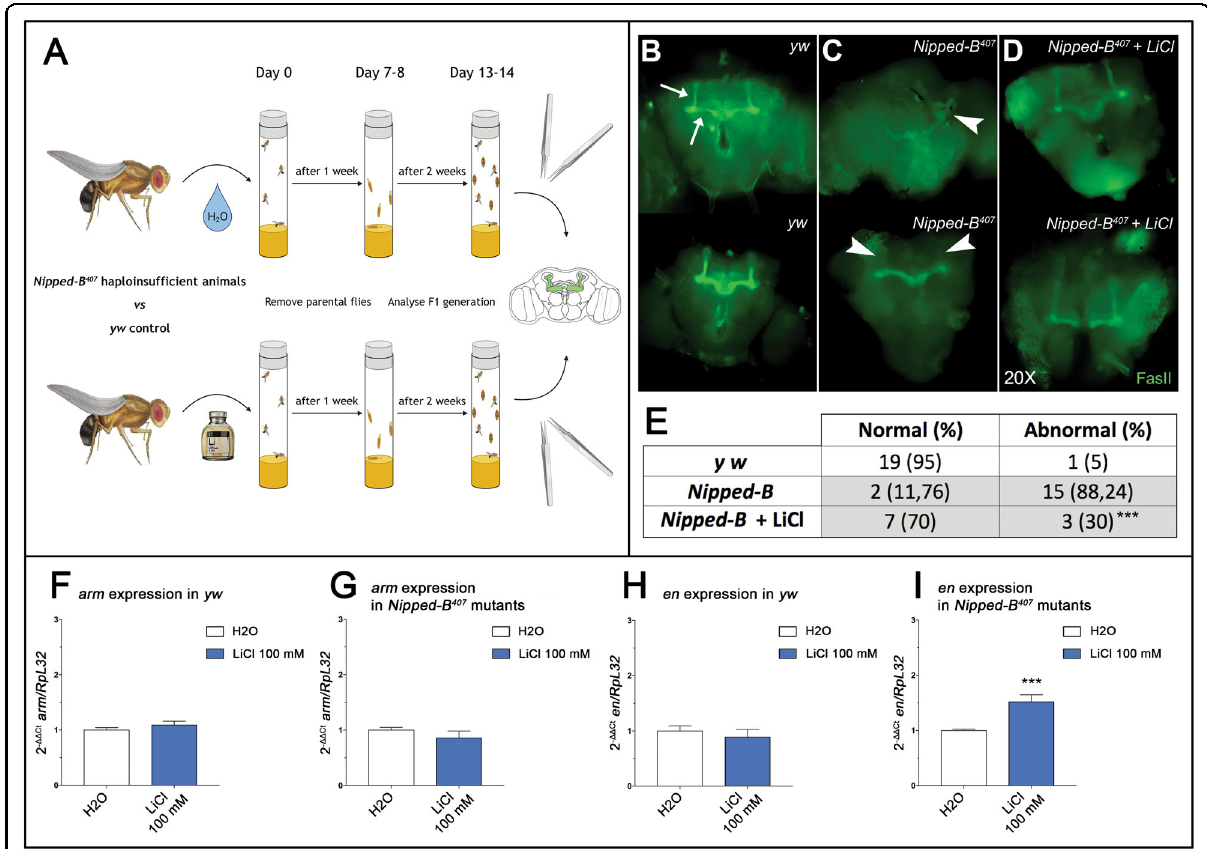
Fig. 2 Lithium rescues mushroom bodies morphology in CdLS D. melanogaster through WNT activation. A Schematic representation of the drug-treatment protocol. B – D Mushroom bodies of adult animals labeled with anti-FasII are shown in green. B Normal morphology of mushroom bodies was observed in yw controls where α , β , and γ lobes can be distinguished by their distinct projection patterns (arrows). C Abnormal mushroom bodies morphology was observed in Nipped-B 407 haploinsuf fi cient adults with a twisted structure (arrowhead in the upper brain) or lacking both α lobes (arrowhead in the lower brain) as example. D Rescue of mushroom bodies morphology is shown in Nipped-B 407 haploinsuf fi cient adults upon treatment with LiCl. E The table reports the total number and percentage of normal or abnormal adult mushroom bodies. Data were analyzed using Fisher ’ s exact test (*** p < 0.005). F – I Histograms show arm ( F , G ) and en ( H , I ) gene expression levels in whole fl ies as 2 - ΔΔ Ct ± SD. Analyses of yw controls are shown in the panels ( F – H ) and analyses of the Nipped-B 407 mutants are shown in the panels ( H , I ). White: water; dark